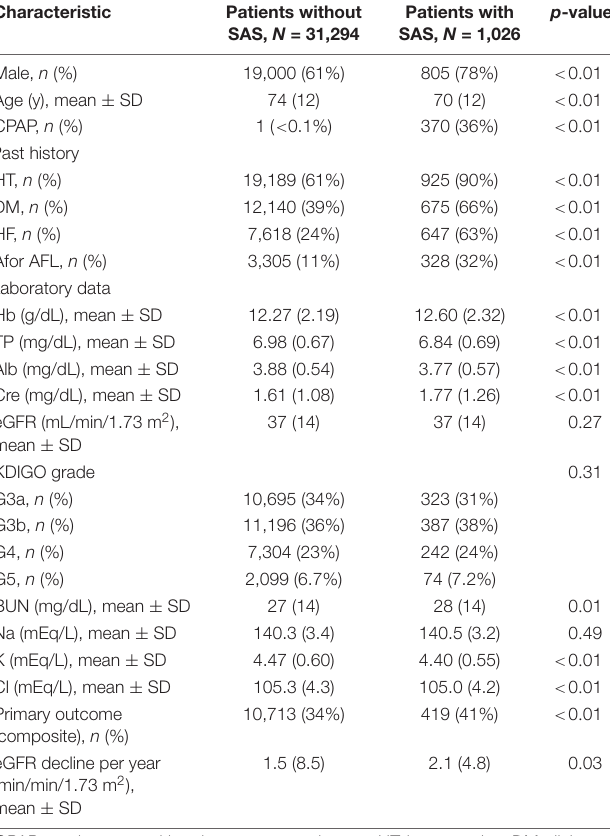
TABLE 2 | Baseline characteristics of patients after propensity score matching. TABLE 1 | Baseline characteristics of patients. Characteristic Patients without Patients with Characteristic Patients without SAS, N = 31,294 SAS, N = 1,026 SAS, N =